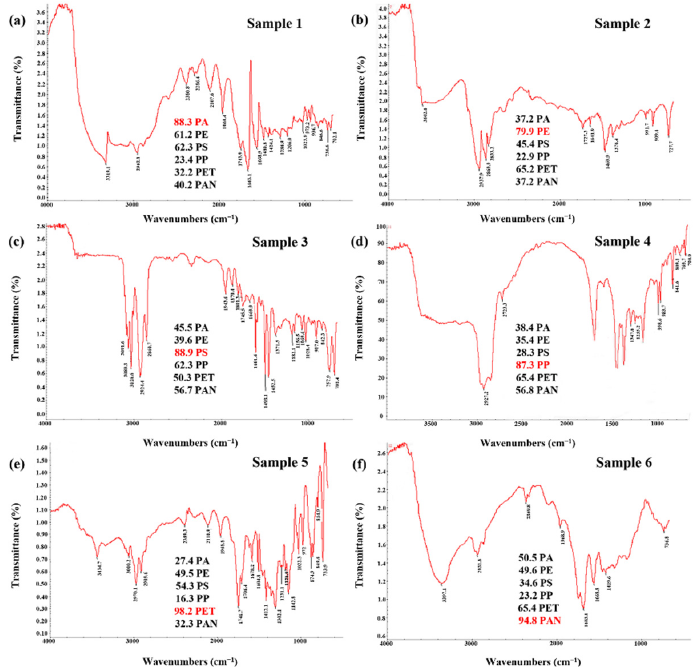
Figure 6. FT-IR spectra of the predominant microplastics in surface water samples from 13 sampling sites in the Pearl River Delta. ( a ) Sample 1 = PA; ( b ) Sample 2 = PE; ( c ) Sample 3 = PS; ( d ) Sample 4 = PP; ( e ) Sample 5 = PET; and ( f ) Sample 6 = PAN.